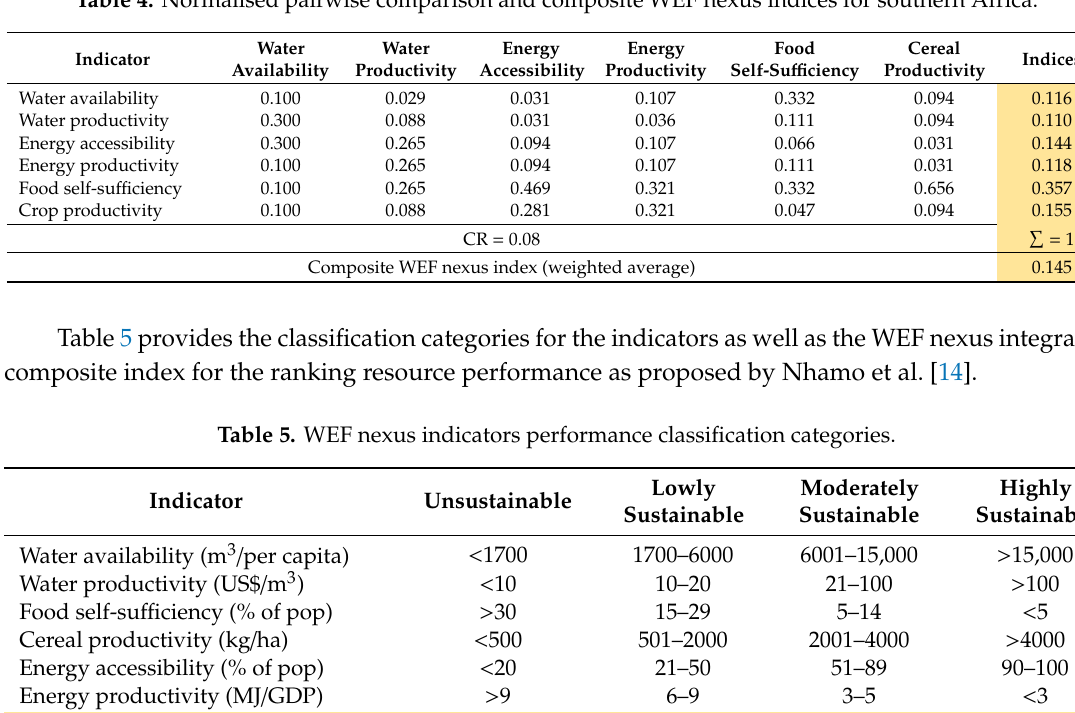
Table 4. Normalised pairwise comparison and composite WEF nexus indices for southern Africa.